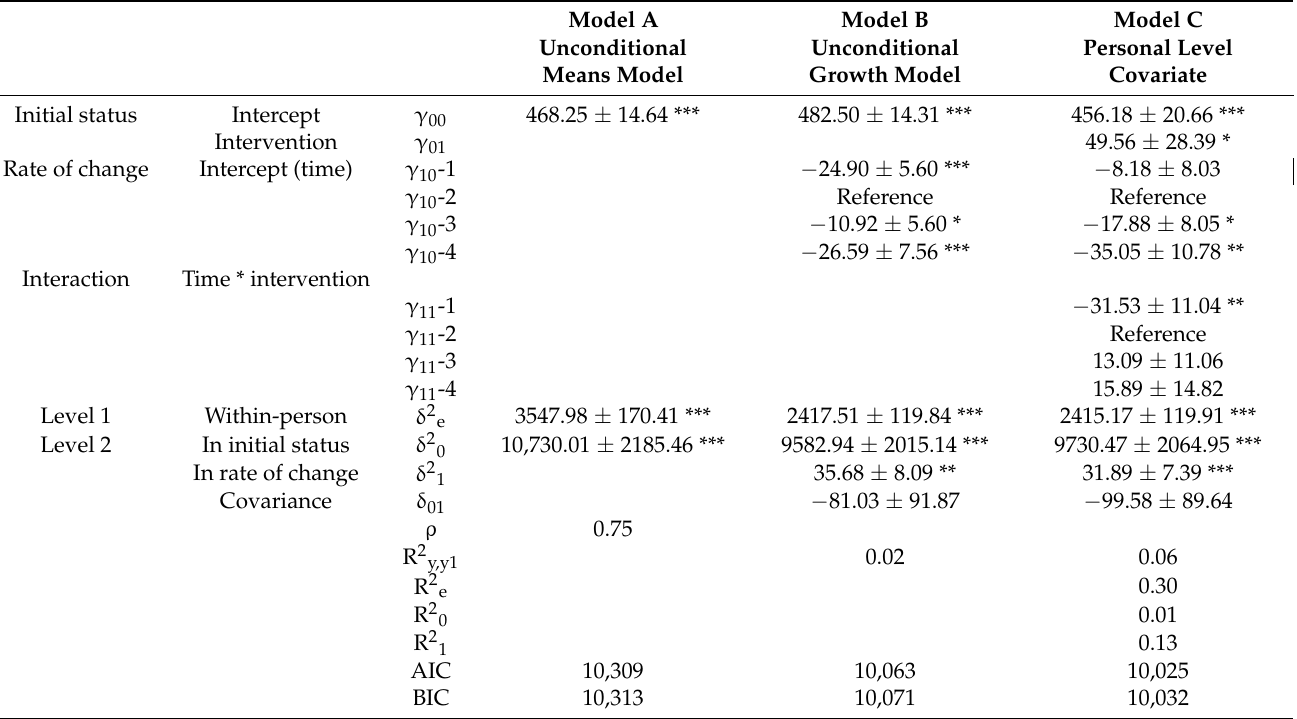
Table 2. Mixed model analyses of variations in sedentary